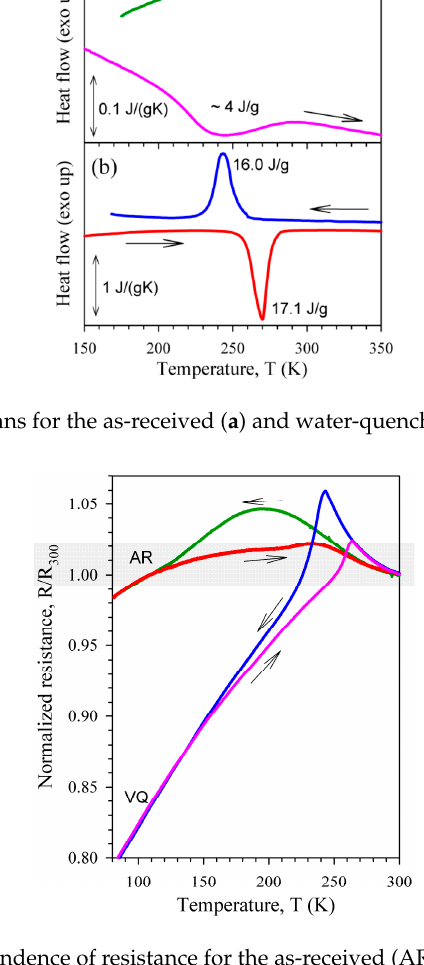
Figure 2. Temperature dependence of resistance for the as-received (AR) and vacuum-quenched (VQ) Ni 50.8 Ti 49.2 samples. Data are normalized to the resistance values at 300 K.